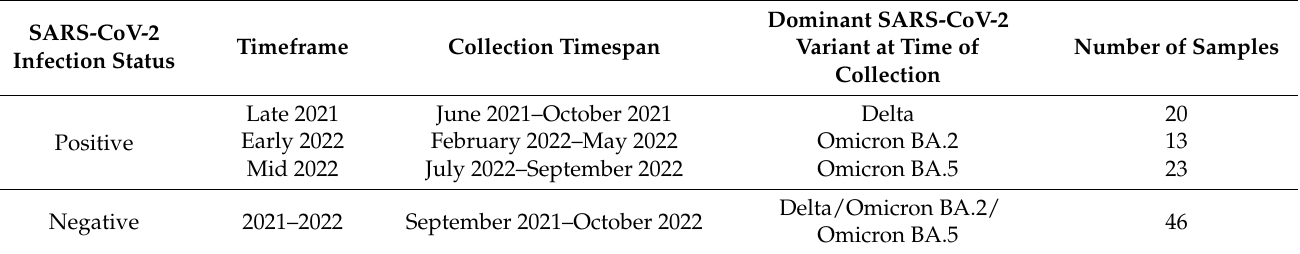
Table 1. SARS-CoV-2-Positive and -Negative